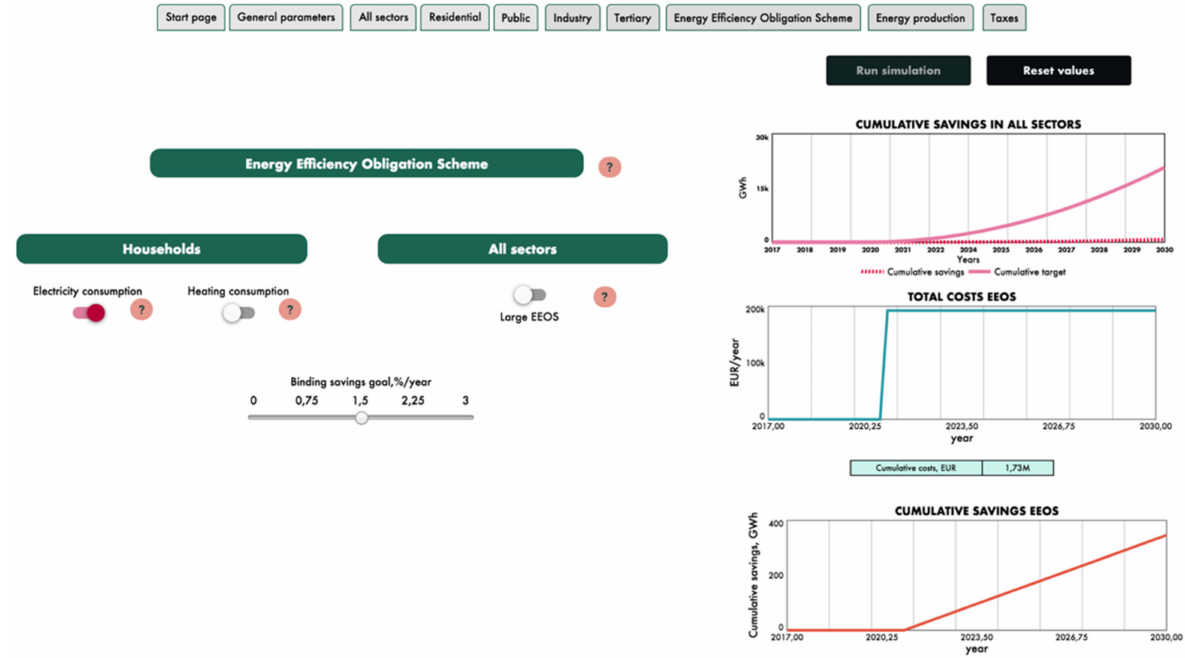
Figure A8. Internet-based model interface for the Energy Efficiency Obligation